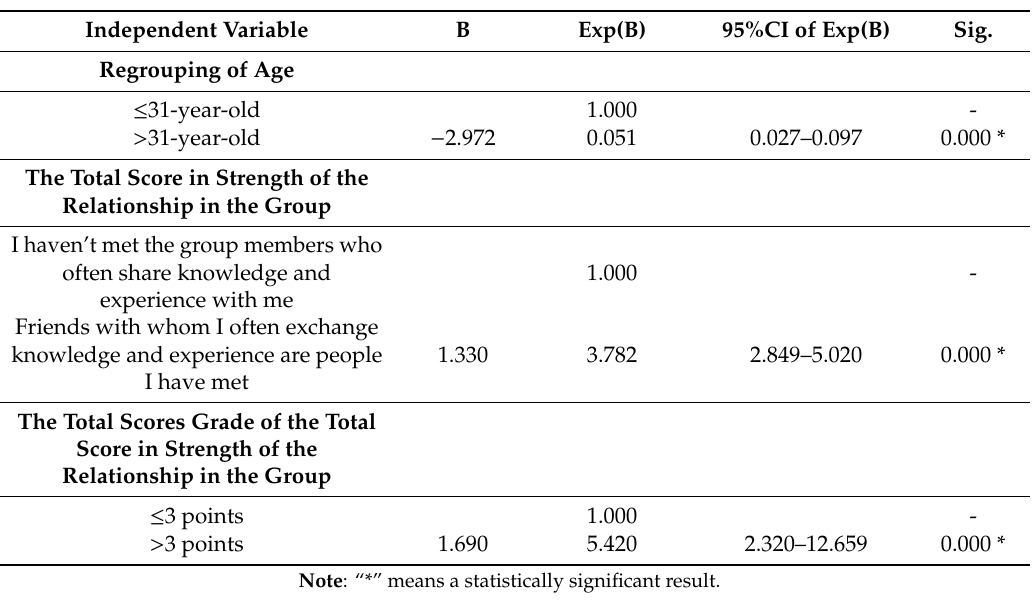
Table 4. The results of multivariate binary logistic regression analysis for social support in patients.